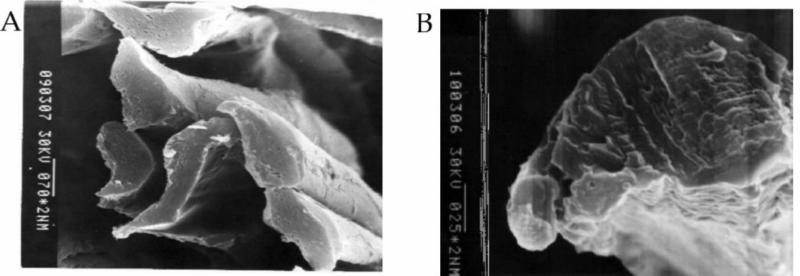
Figure 2. Scanning electron microscopy images characterizing surface of natural silk Bombyx mori and cross-section of fibres. ( A ) a group of fibres; ( B ) single